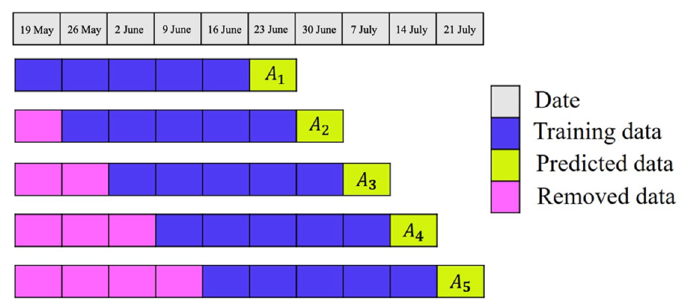
Figure 7. Schematic representation of rolling error compensation. Table 4. The result of calculating compensation value at different time